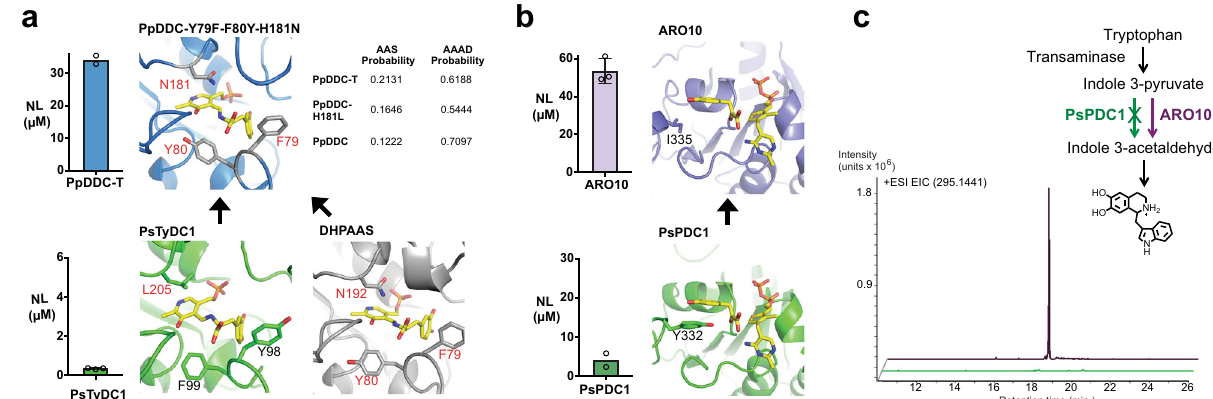
Fig. 7 Replicating norlaudanosoline pathways using homologous enzyme templates. a PsTyDC1 (green) is exchanged with an engineered PpDDC template (blue) via three active site gain-of-function substitutions, Y79F, F80Y, and H181N, to promote DHPAAS activity. In accordance with the resulting increase in AAS activity, these three substitutions result in increased SVM probability scores for AAS prediction, and reduced SVM probability scores for AAAD prediction. Norlaudanosoline (NL) production from L-DOPA was compared using PsTyDC1 in strain T1-10-DE3 ( t = 44 h, n = 3) and PpDDC-Y79F- F80Y-H181N (PpDDC-T) in strain DT-02-DE3 ( t = 40.5h, n = 2). Culture conditions for each strain are described in the methods section. b PsPDC1 (green) is exchanged with S. cerevisiae ARO10 (purple) for higher PPDC activity in E. coli . Production of norlaudanosoline (NL) from L-DOPA by PsPDC1 in strain P1-02-AI is shown ( t = 44 h, n = 2). Production of norlaudanosoline (NL) from L-DOPA and dopamine by ARO10 in strain A1-01-DE3 is compared ( t = 44 h, n = 3). Culture conditions are described in the methods section. For panels a and b , Samples from individual cultures were analyzed two or three times ( n = 2 or n = 3) to generate bar graphs in Prism 7, with error bars representing mean values + / − standard deviations. c Strain A1-01-DE3 containing ARO10 (purple) metabolizes tryptophan in TB medium to produce an indole 3-acetaldehyde derived indole alkaloid byproduct ( t = 61 h), as indicated by the extracted ion chromatogram (EIC). Strain P1-02-AI containing PsPDC1 (green) did not readily convert indole 3-pyruvate to indole 3-acetaldehyde, as indicated by no detectable indole alkaloid byproduct ( t = 61 h). Source data are provided as a Source Data fi